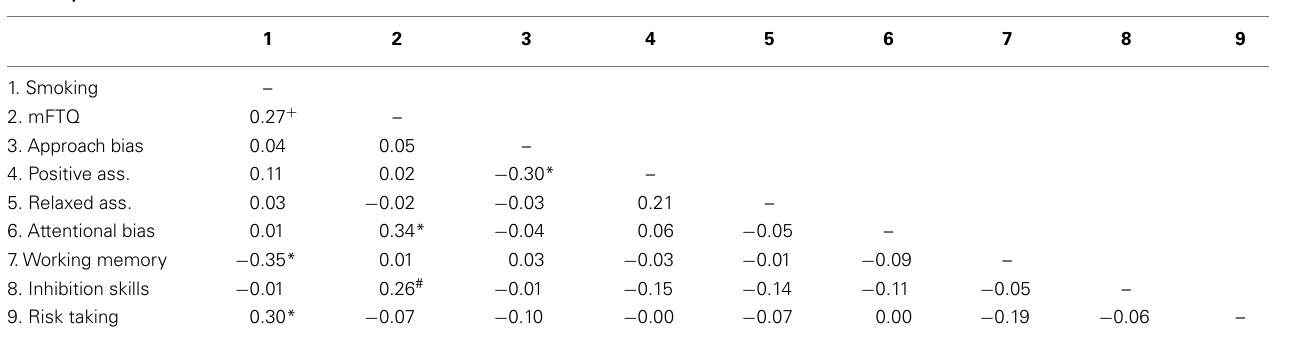
Table 1 | Correlations between model variables